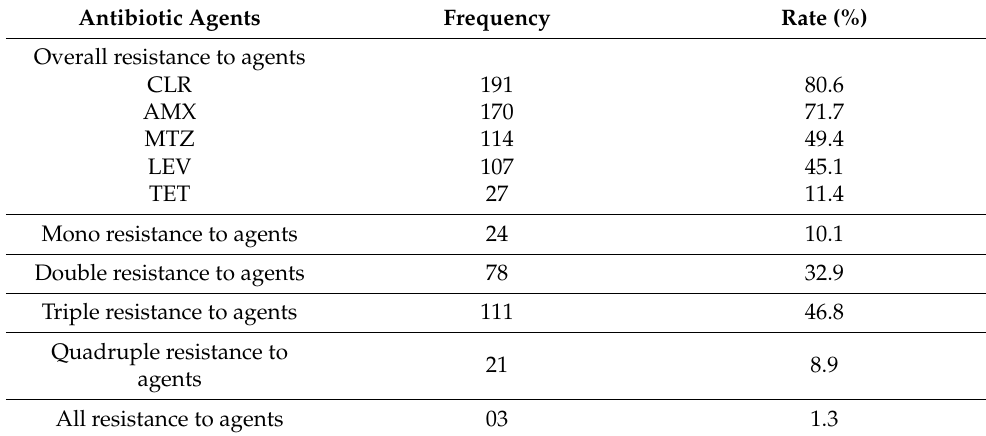
Table 3. Antibiotic resistance of Helicobacter pylori among pediatric patients ( n = 237).